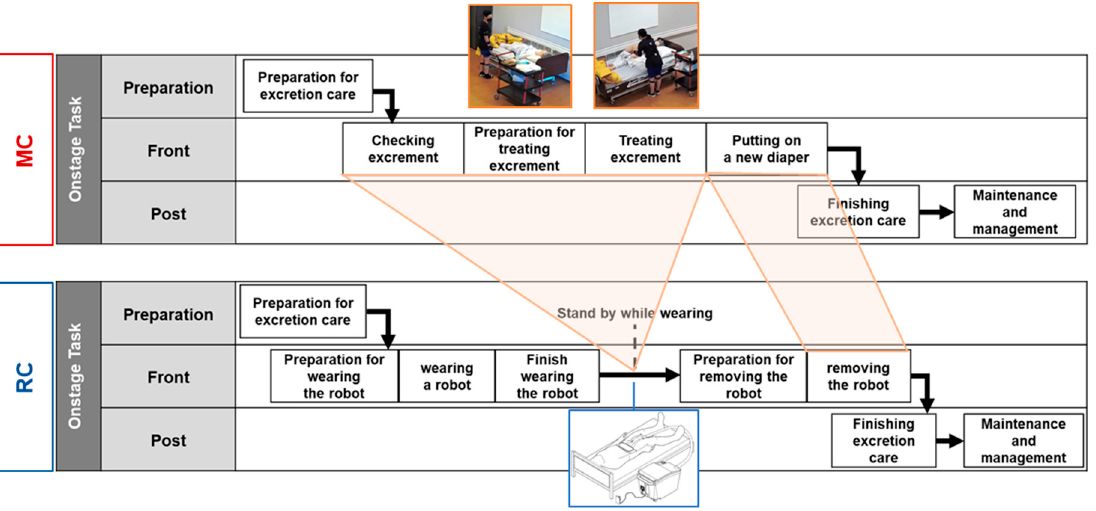
Figure 4. The structure of the hierarchical excretion care task (upper figure: manual care using a paper diaper; lower figure: robot-aided excretion care).